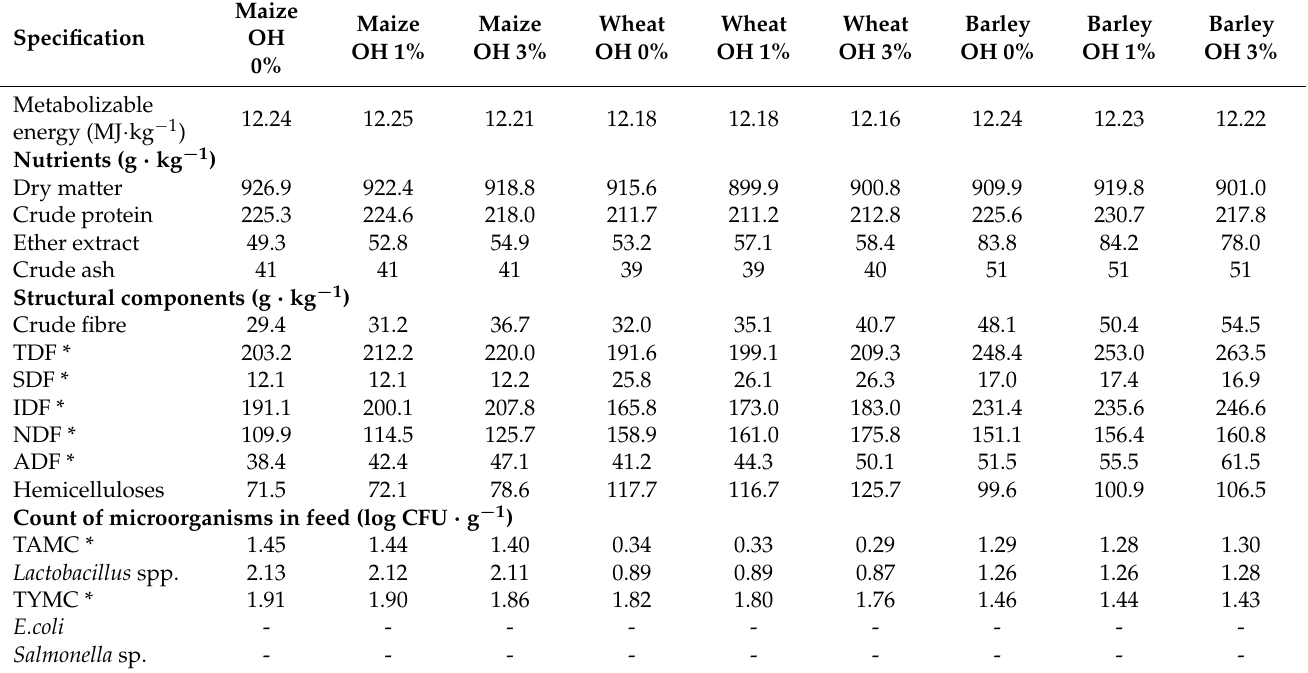
Table 4. Chemical, structural, and microbial composition of experimental